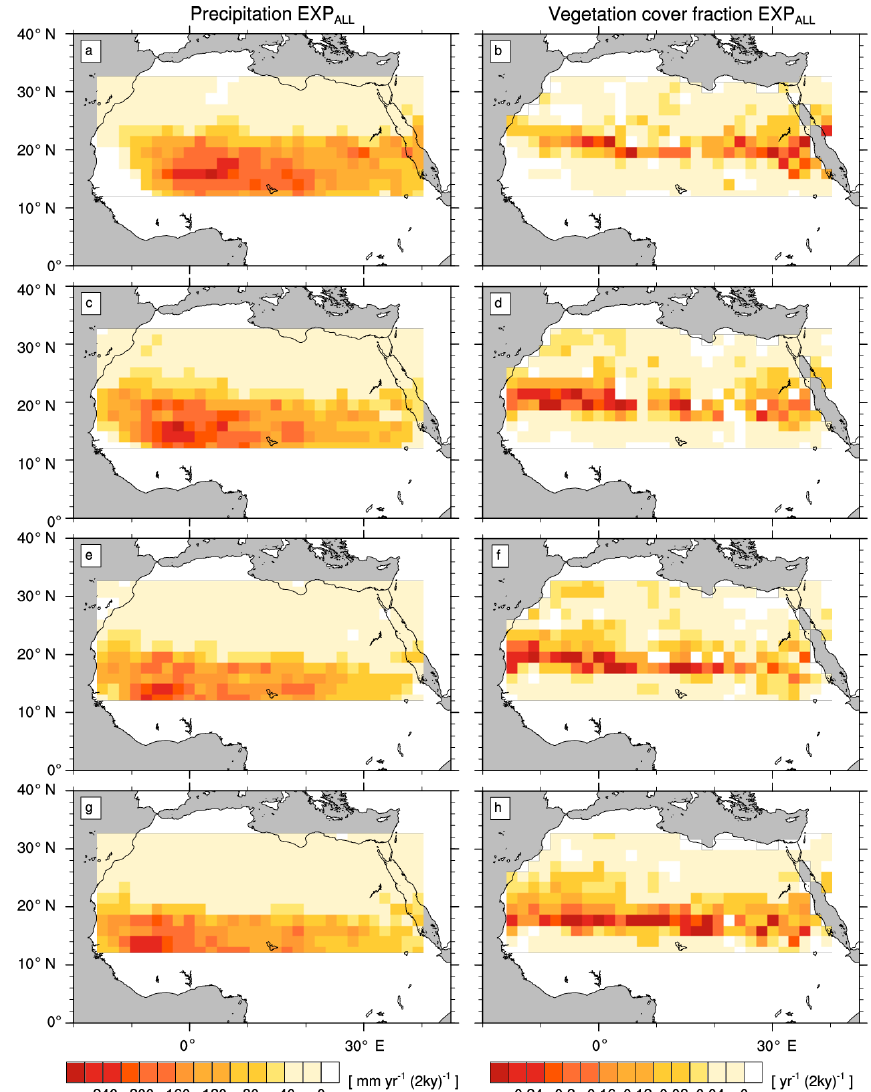
Figure 5. Transition rates from the green Sahara to the desert state for precipitation P (left column) and vegetation cover fraction veg max (right column) of a simulation with the standard PFT set (EXP ALL ). Plots depict differences between consecutive time slices (100-year averages): 6–8kyr (a, b) , 4–6kyr (c, d) , 2–4kyr (e, f) , and 0–2kyr (g, h)